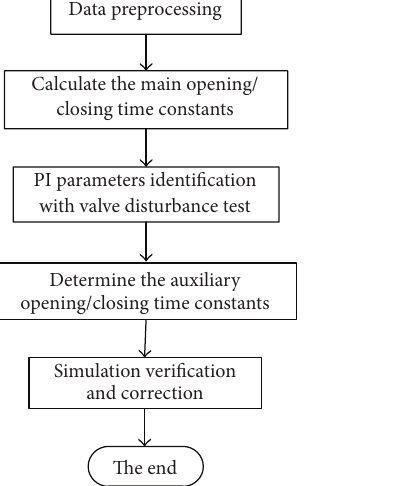
Figure 4: The parameter identification process of servo and actua- tor.